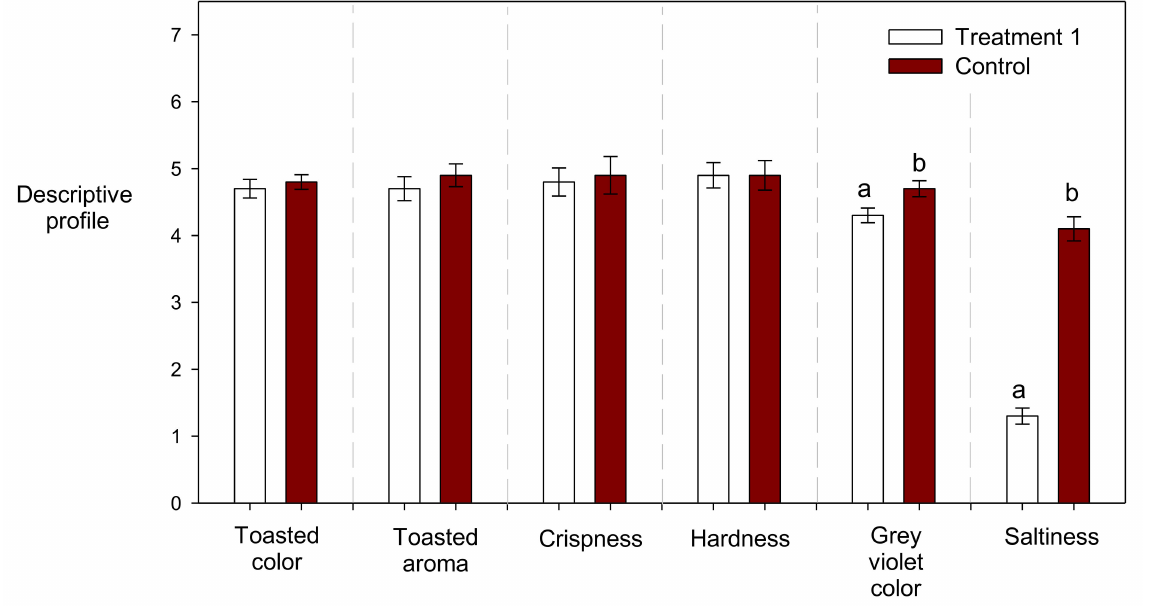
Figure 2. Descriptive profile of a commercial formulated cracker (control) and reduced AA and HMF crackers. Different low case letters indicate statistically significant differences ( p < 0.05) between the control sample and the treatment